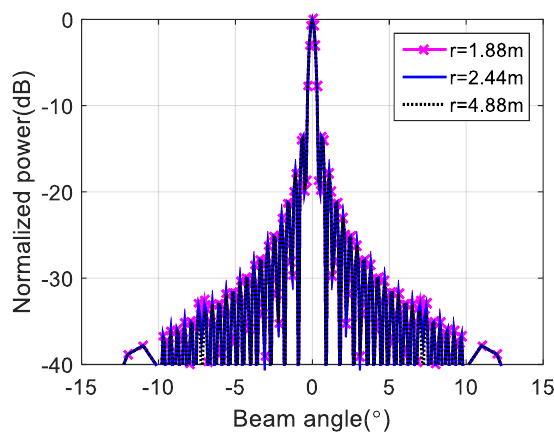
Figure 5. Beam pattern of subarray ( a ) and sampling function ( b ) in far-field.